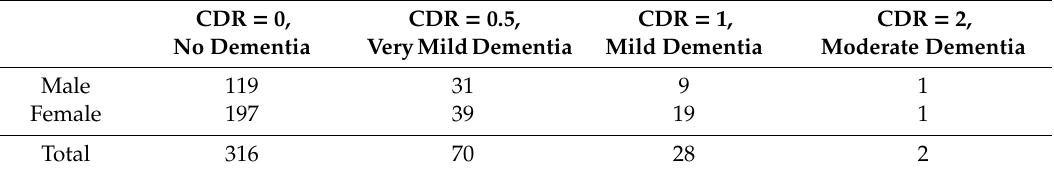
Table 2. Clinical dementia rating (CDR) frequency distribution by gender.